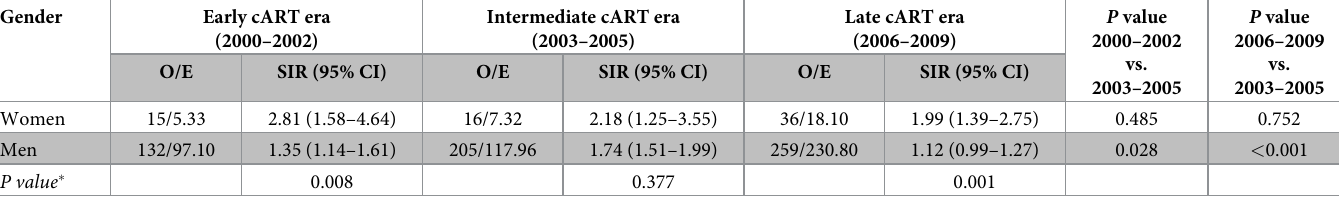
The SIRs for MI, calculated according to gender in each calendar period, are shown in Table 2. All the SIRs were significant, with the exception of the SIR among men living with HIV in the last calendar period. No significant difference in SIRs across the calendar periods was observed among women (p > 0.05), for whom the estimated SIR in the last period was 1.99 (95% CI: 1.39–2.75). In contrast, the SIRs among men showed a significant increase from early to inter- mediate cART era (p = 0.028), and a significant decrease from intermediate to late cART era (p < 0.001). The risk was only marginally elevated in the last calendar period, with a SIR of 1.12 (95% CI: 0.99–1.27). Comparing SIR among men and women living with HIV in each calendar period, the relative risk of MI was higher among women than men living with HIV in 2000– 2002 (p = 0.008) and in 2006–2009 (p = 0.001) but not in 2003–2005 (p = 0.377). Among HIV-infected individuals with CD4 cell counts � 500/ μ L for at least 2 years and viral load � 500 copies/mL on cART started at least 6 months previously, the risk was not higher than in the general population, with SIRs of 1.04 (95% CI: 0.12–3.76) for women and